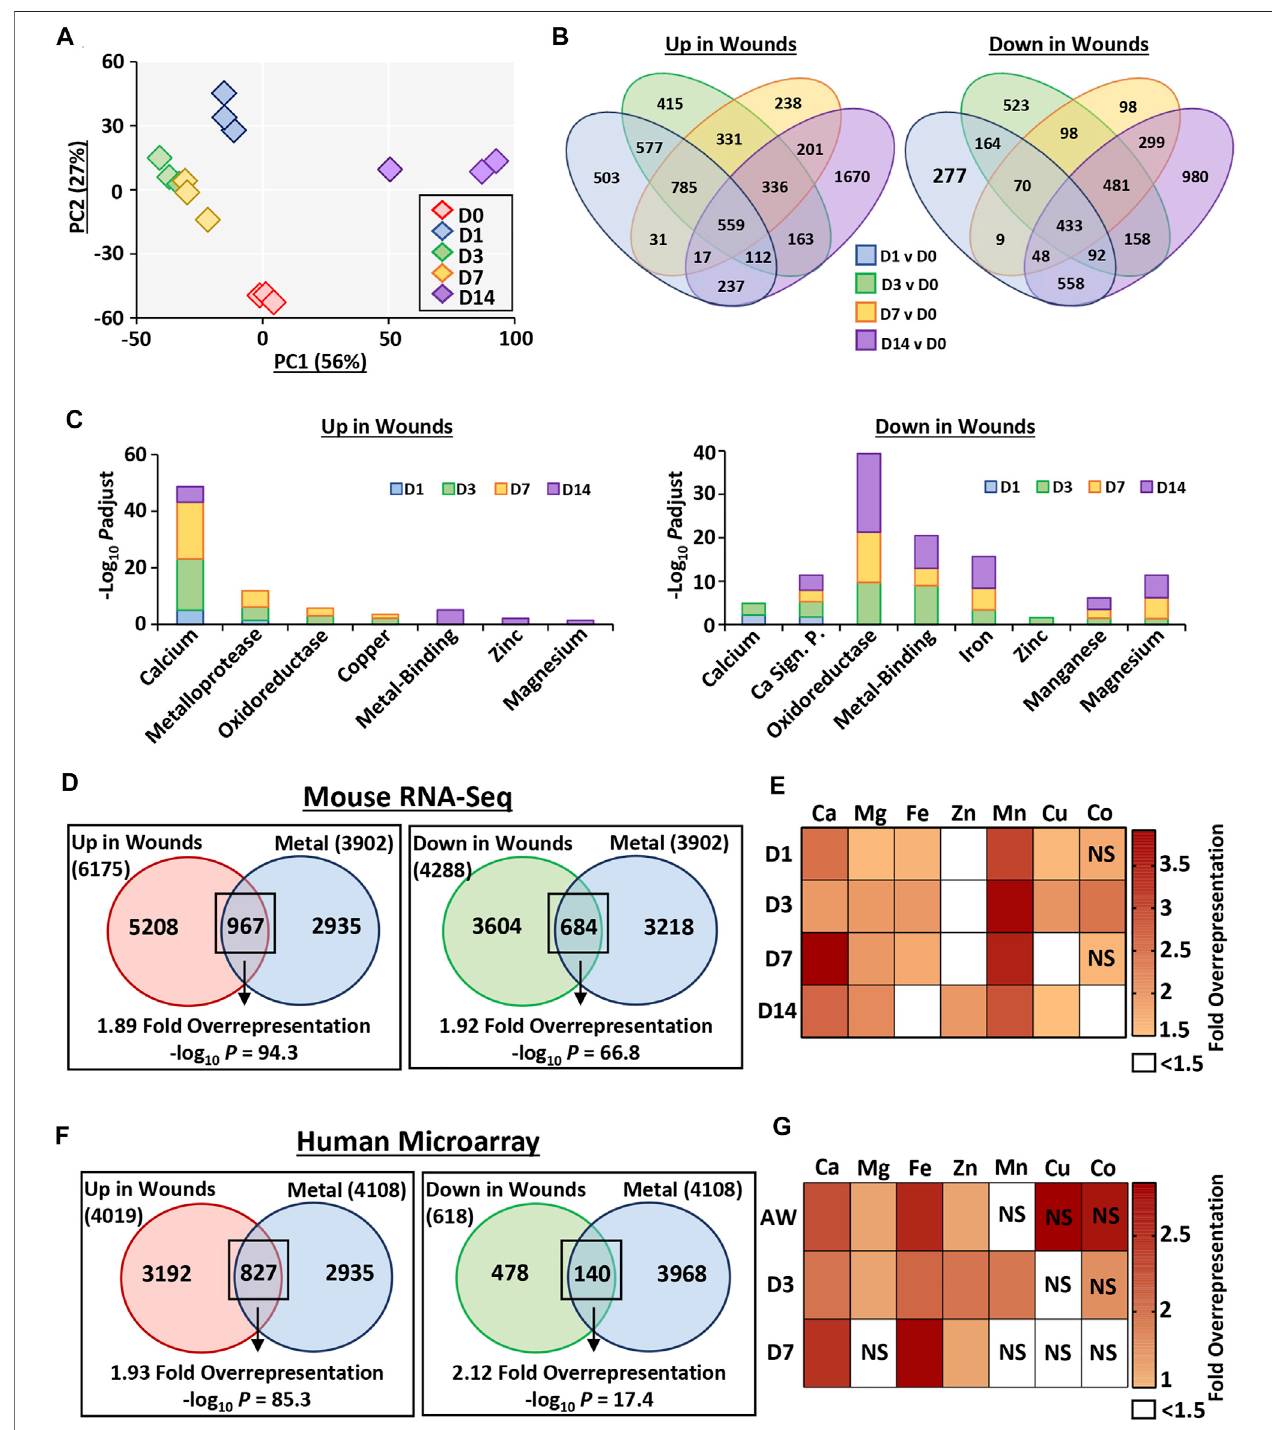
FIGURE 3 | Metal-linked genes are considerably overrepresented in mouse and human wound transcriptomes. Murine wounds were collected at days 1, 3, 7 and 14 post-wounding for RNA-Sequencing. D0 (cid:2) normal skin. n (cid:2) 3 mice per group. Principal component (PC) analysis (A) . Percentage (%) contribution. Venn diagrams showdifferentiallyexpressedgenes(DEGs)inwoundsversusD0.Log 2 foldchange ≥ 0.58andBenjamini-Hochbergadjusted p value( P adjust) < 0.05 (B) .DEGslinkedto metals by functional annotation (C) . Overrepresentation analysis demonstrates metal-linked (UniProt KB) genes are also injury-associated DEGs (D) . Wound- upregulated DEGs further separated by metal and time-point in (E) . Metal enrichment was con fi rmed in DEGs upregulated in human wounds via microarray (F – G) . AW, acute wound; D, day post-injury; NS, non-signi fi cant.